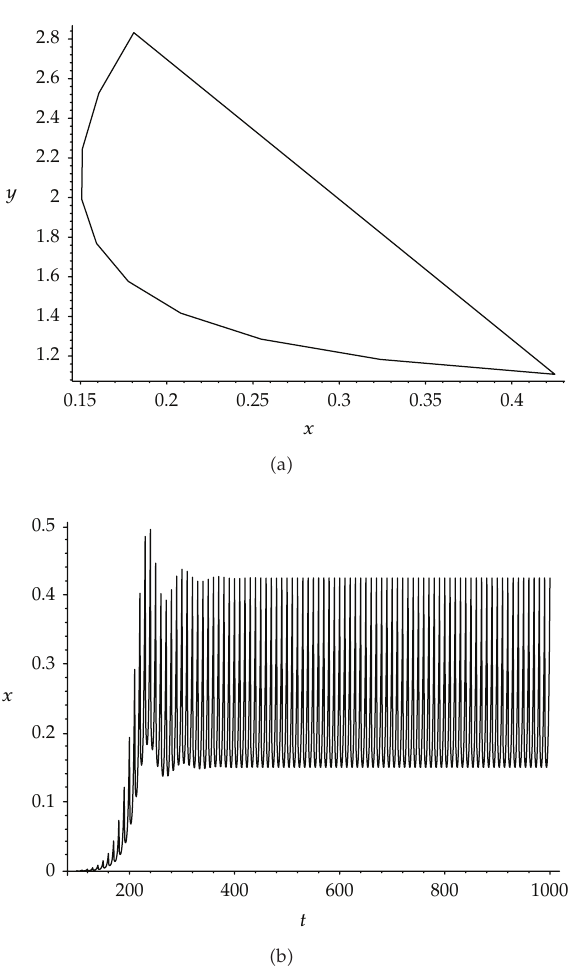
Figure 2: (cid:2) a (cid:3) A period T attractor when T (cid:7) 10, (cid:2) b (cid:3) time series algae population when T (cid:7)